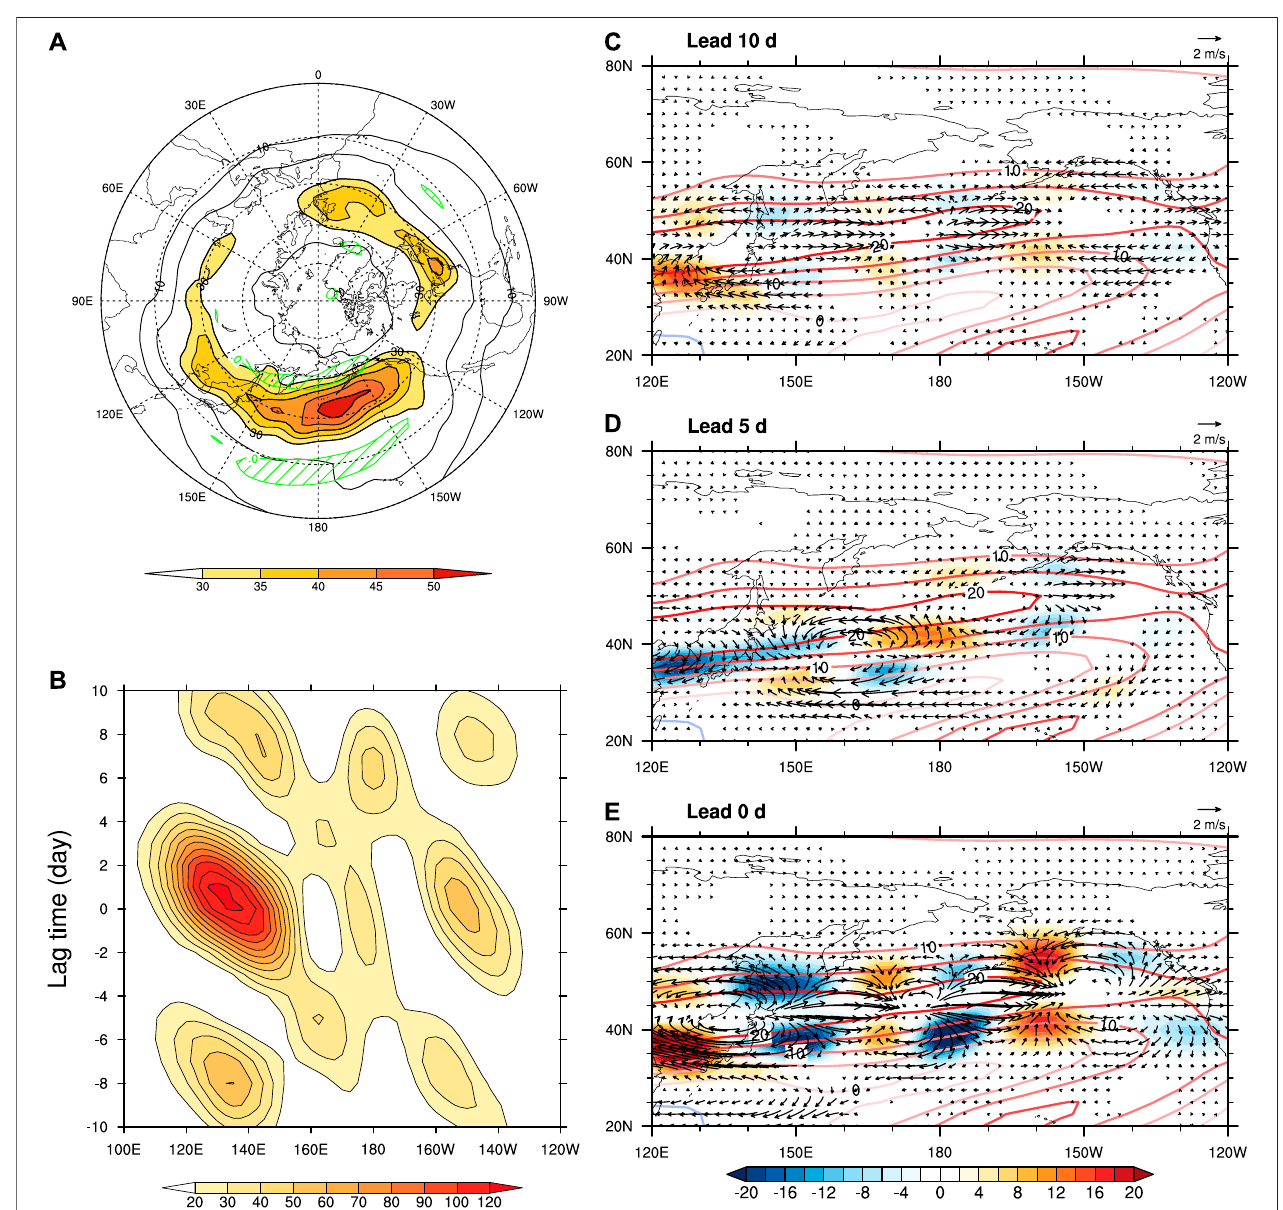
FIGURE 8 | (A) 10 – 30 days fi ltered kinetic energy (KE, unit: m − 2 s − 2 ) and meridional gradient of the absolute vorticity of the basic fl ow (green line, unit: m − 1 s − 1 ) at 200 hPa during July – August of 1980 – 2019; (B) Time-longitude cross section of the vertically integrated 10 – 30 days fi ltered KE regressed onto WPSH_SMI_10-30d along 30 ° -60 ° N (unit: m − 2 s − 2 ), positive (negative) lagged time denotes that 10 – 30 days fi ltered KE lags (leads) WPSH_SMI_10-30d , for example, “ − 10 ”